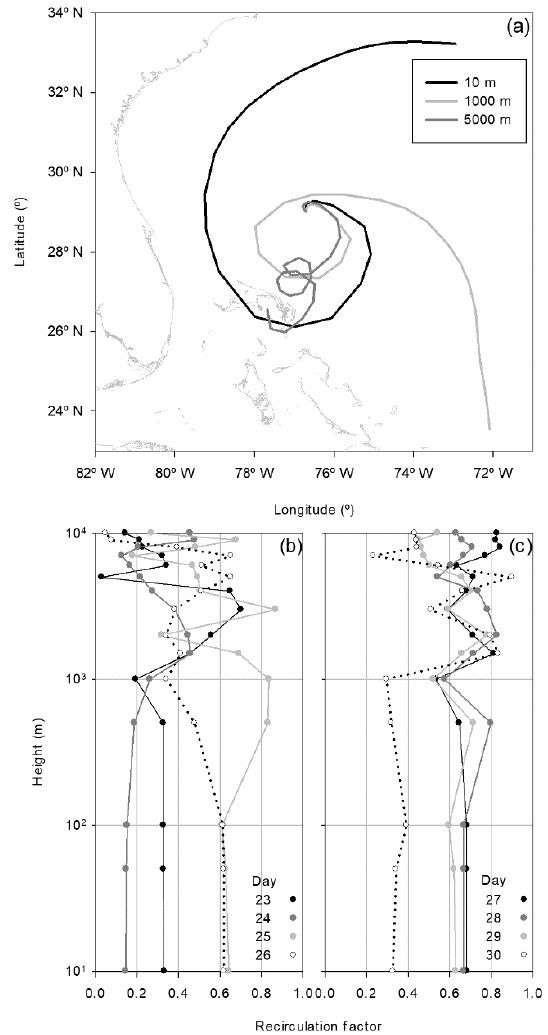
Figure 7. ( a ) One-day backward air parcel trajectories calculated for selected heights on 27 Octo- ber 2012 at 13.30 UTC. Trajectories are spirals near the ground. However, loops are obtained in the mid troposphere. ( b , c ) Profiles of the recirculation factor at selected dates (at 13.30 UTC, except on 30 October 2012, which is at 7.30 UTC). Nearly uniform factors are observed in the low